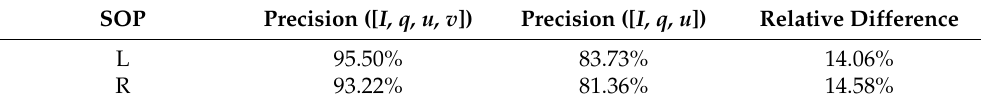
Table 7. Precision of Isochrysis